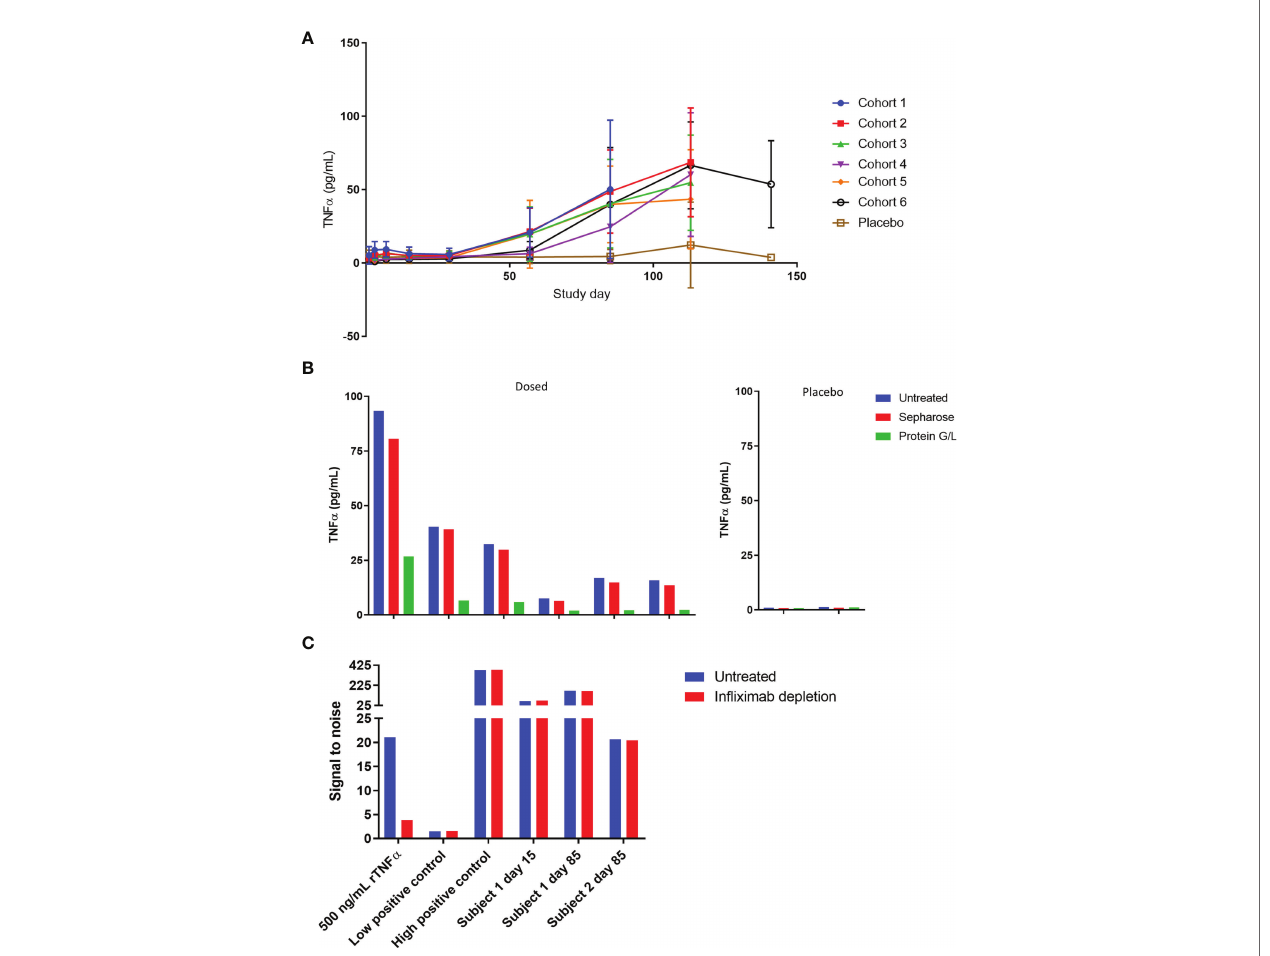
FIGURE 7 | TNF a is bound to immunoglobulin and accumulates in serum over time. (A) Serum TNF a was measured for all subjects in the SAD cohorts throughout the course of the study. (B) Serum samples from cohort 1 at day 85 were pre-treated with protein G/L beads or blank sepharose beads and tested alongside untreated samples in the TNF a assay to assess whether TNF a was bound to immunoglobulin. (C) Serum samples were pre-treated with excess in fl iximab and re- tested in the ADA assay to con fi rm that the assay was not yielding false positive results due to 1:1 complexes of TNF a and endogenous anti-TNF a antibody. A high concentration of TNF a known to give a false positive was used as a control and tested alongside low and high positive controls (polyclonal anti-AMG 966